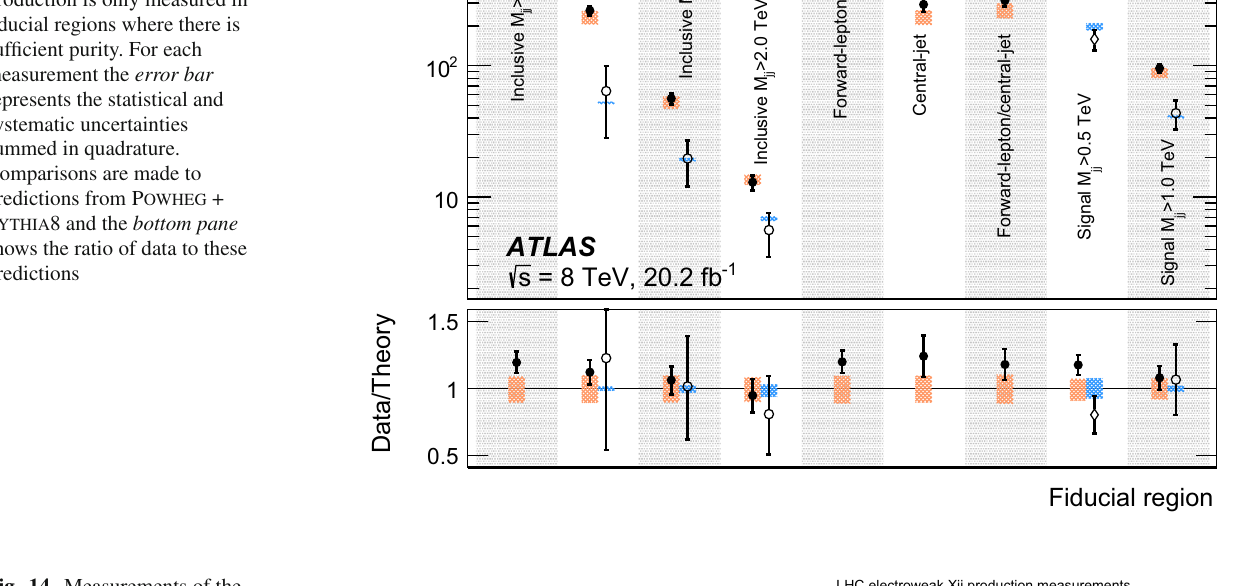
Fig. 14 Measurements of the cross sections times branching fractions of electroweak production of a single W , Z , or Higgs boson with two jets at high dijet invariant mass and in fiducial measurement regions. For each measurement the error bar represents the statistical and systematic uncertainties summed in quadrature. Shaded bands represent the theory predictions. The M jj threshold defining the fiducial Zjj region differs between ATLAS and CMS, leading to different inclusive cross sections